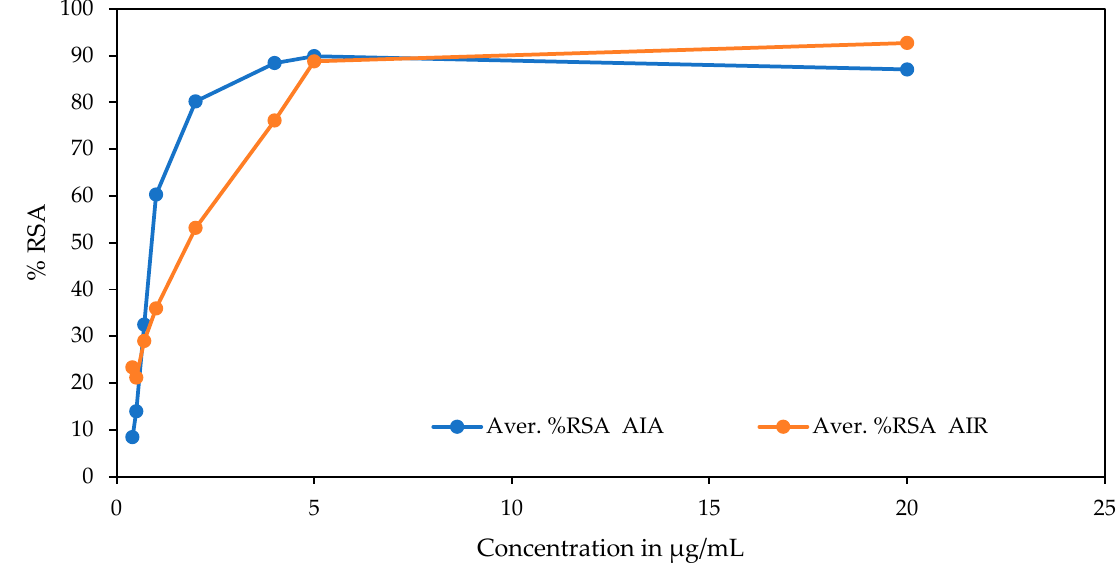
4 of 19 Table 1. Result summary of IC 50 and R 2 values.